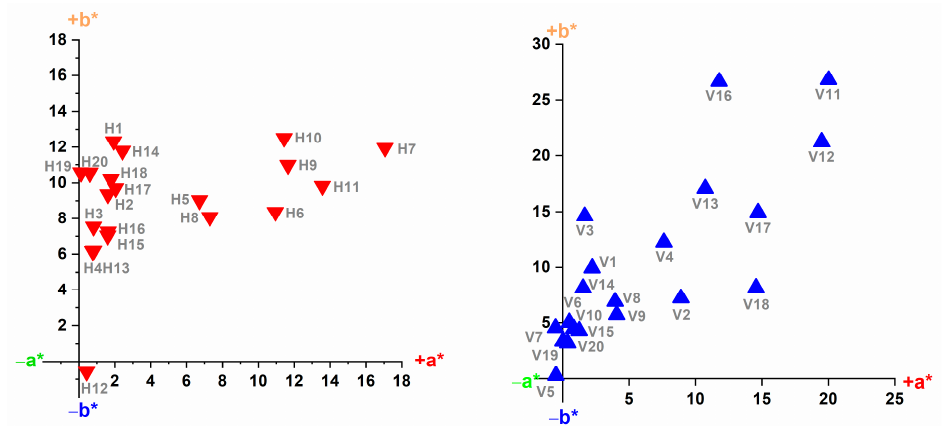
Figure 6. Color coordinates a* and b* of the materials analyzed in situ. Left : horizontal surface finishes. Right : vertical surface finishes.